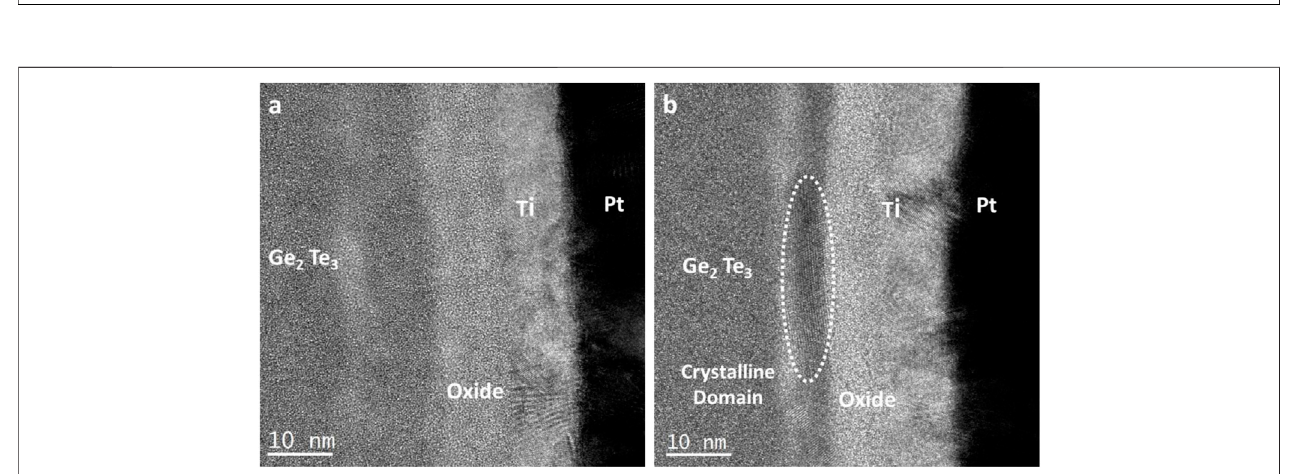
Frontiers in Electronics |